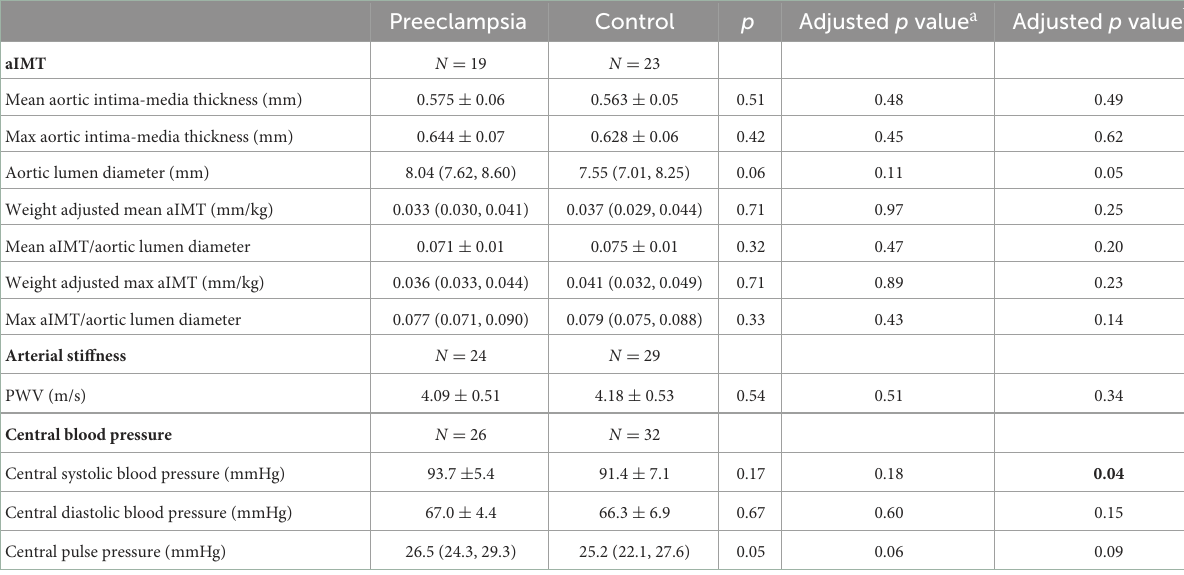
TABLE 2 All vascular outcomes stratified by exposure to preeclampsia vs. normotensive pregnancy. Preeclampsia Control p